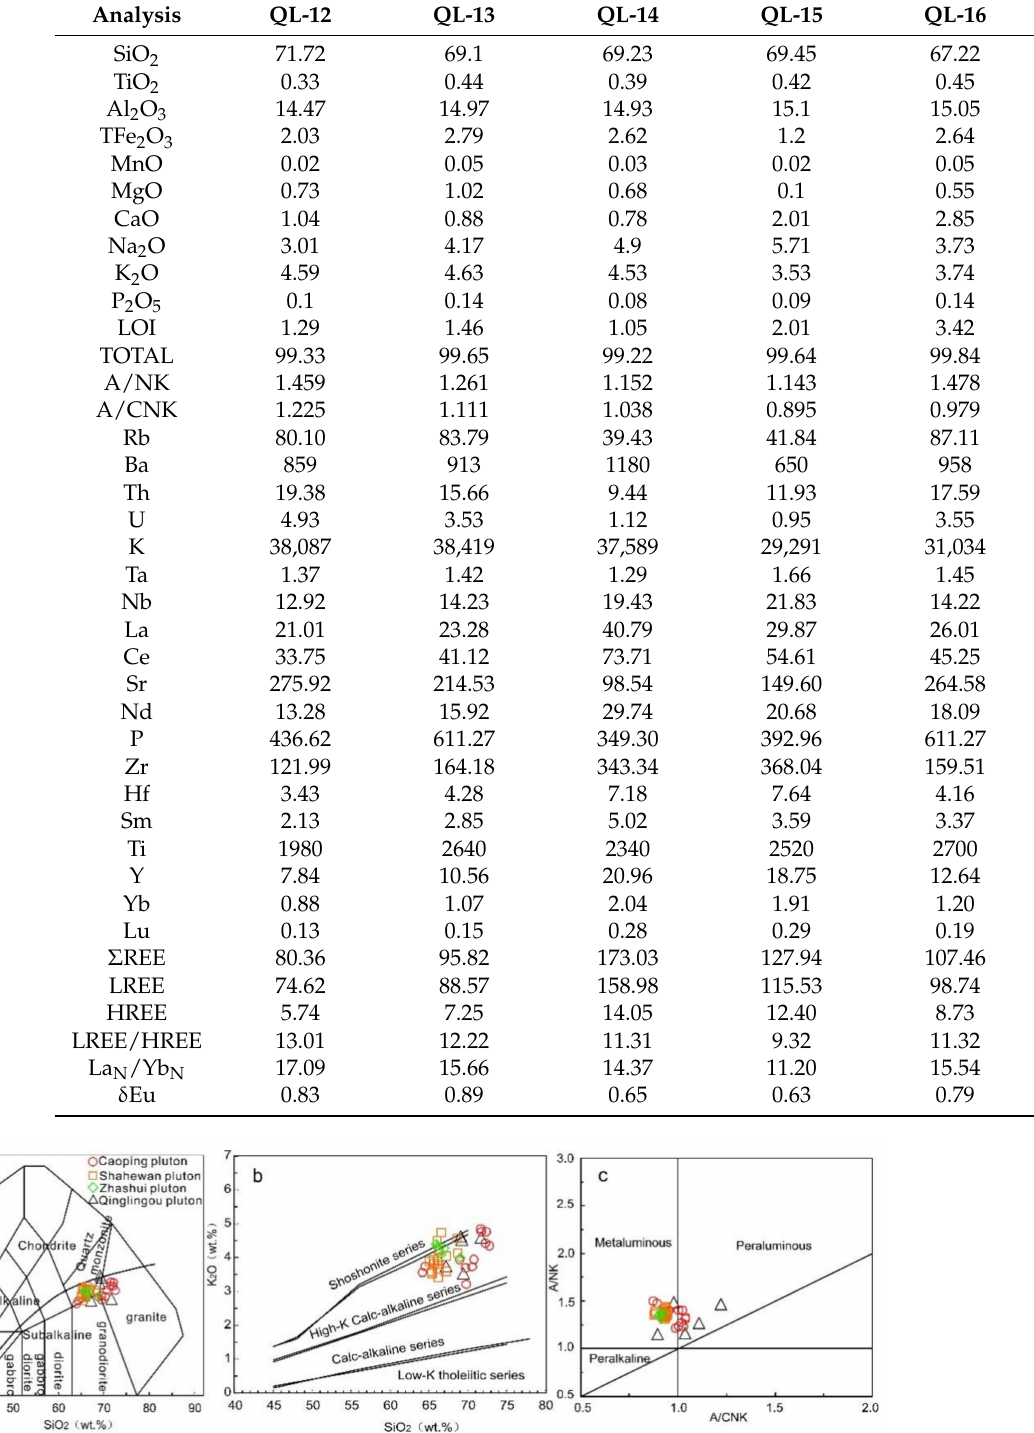
Table 1. Major (wt.%) and trace elements(ppm) of the granite porphyries from the Qinglingou gold deposit.